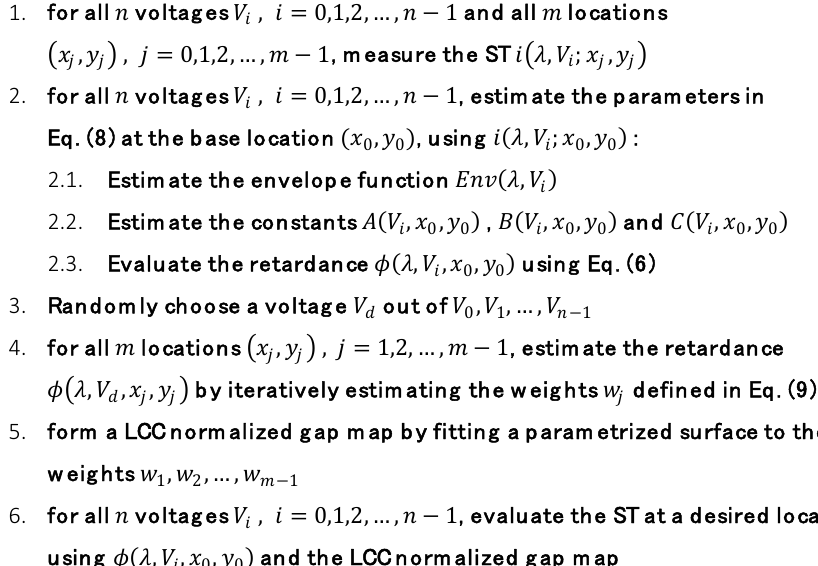
Figure 4. The spatial estimation algorithm. The ST is measured at several locations and voltages. It is then parametrically modeled at the base location ( x 0 , y 0 ) , and its spatial variations are estimated. This allows to evaluate the ST at a desired location.